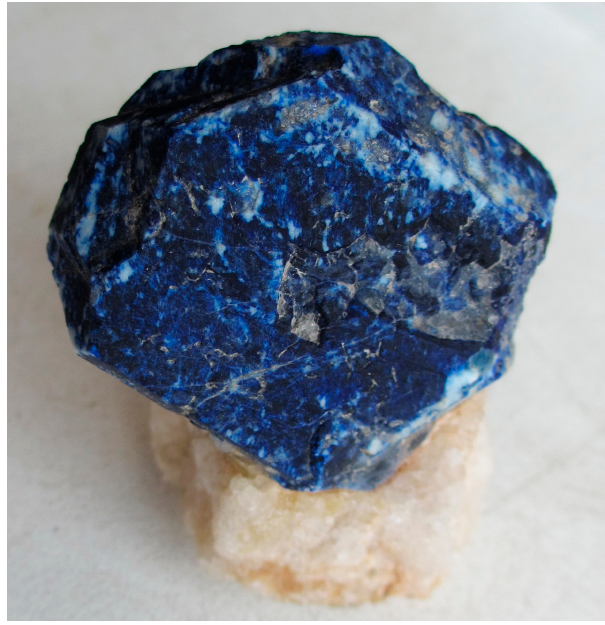
Figure 2. Twin of a deep blue sulfide-rich lazurite extracted from calcite marble (white). Sample 7. Field width: 4.5 cm. Photographer: Nikita V. Chukanov.